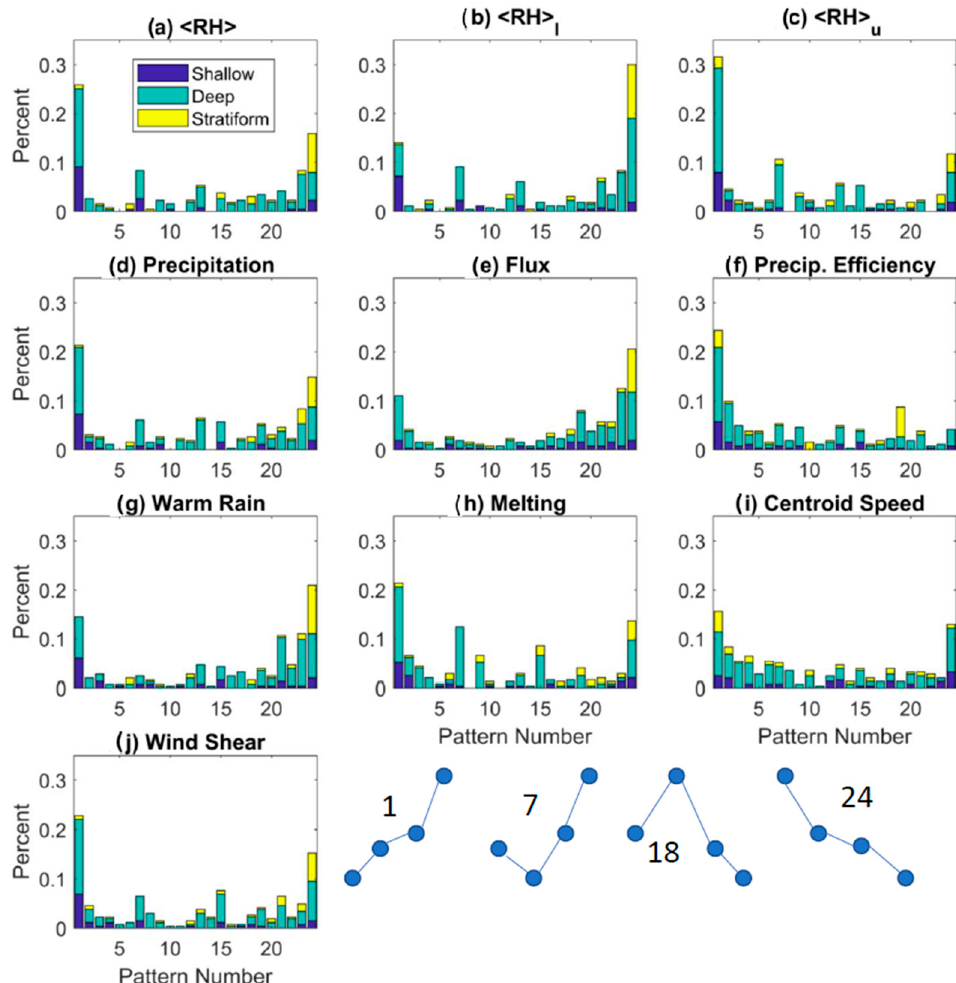
Figure 4. The fractional frequency among all tracked clouds that the normalized evolution for each cloud and environmental quantity exhibits the listed pattern number. Some example common pattern shapes. The various panels indicate the relative frequency of occurrence of the variable ordinal patterns for ( a ) <RH>, ( b ) <RH> l , ( c ) <RH> u , ( d ) the precipitation rate, ( e ) the moisture flux, ( f ) the precipitation efficiency, ( g ) the warm rain generation, ( h ) the generation of rain due to melting, ( i ) the speed of the motion of the centroid location, and (j ) the magnitude of mean wind shear.